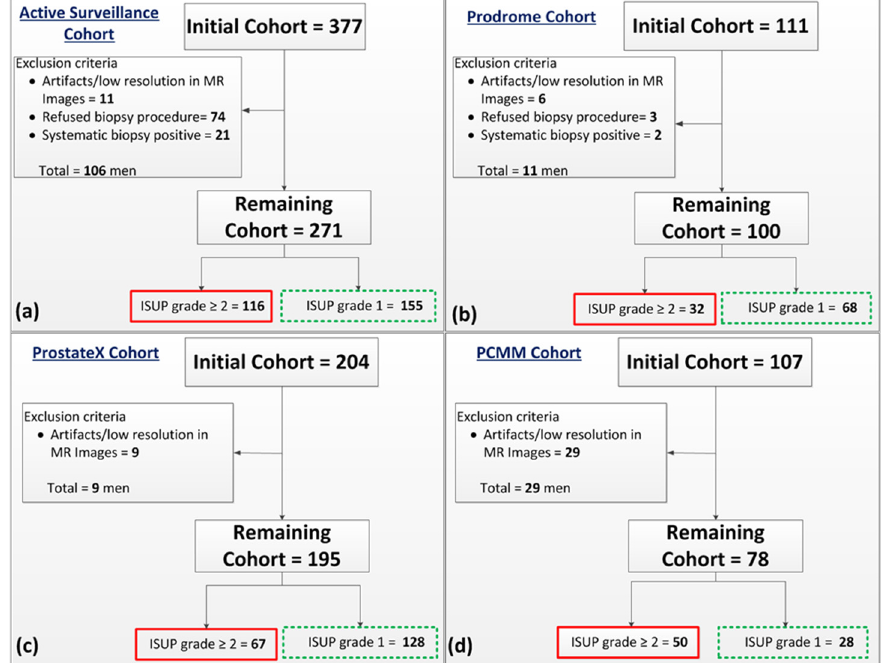
Figure 1. Flow diagram of patient exclusion and inclusion of the four cohorts used in this study: ( a ) Active Surveillance, ( b ) Prodrome, ( c ) ProstateX, and ( d ) PCMM. ISUP : International Society of Urological Pathology.